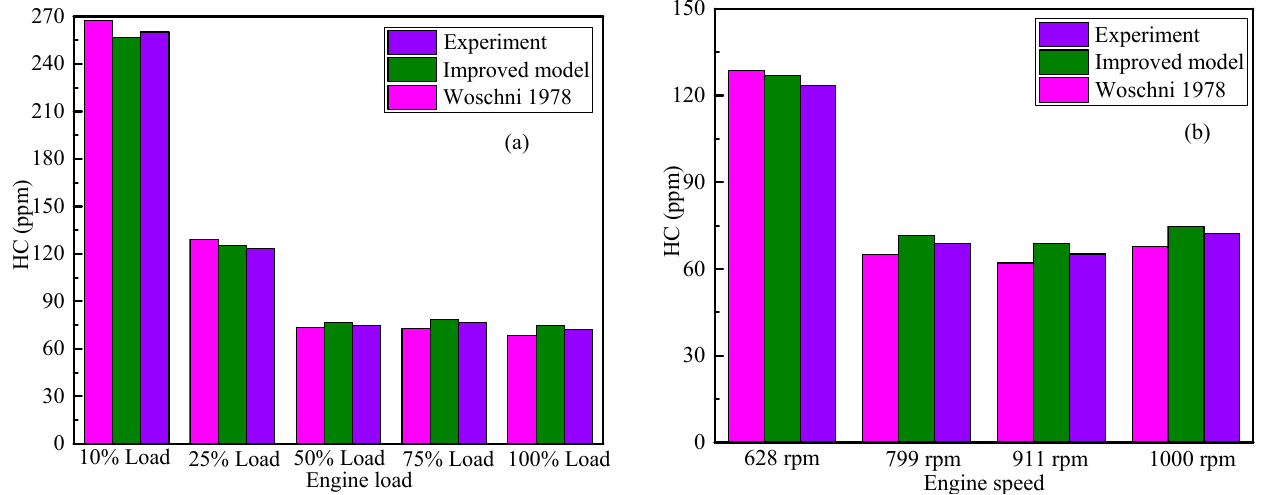
Figure 9. Comparisons of HC emission under different load conditions.